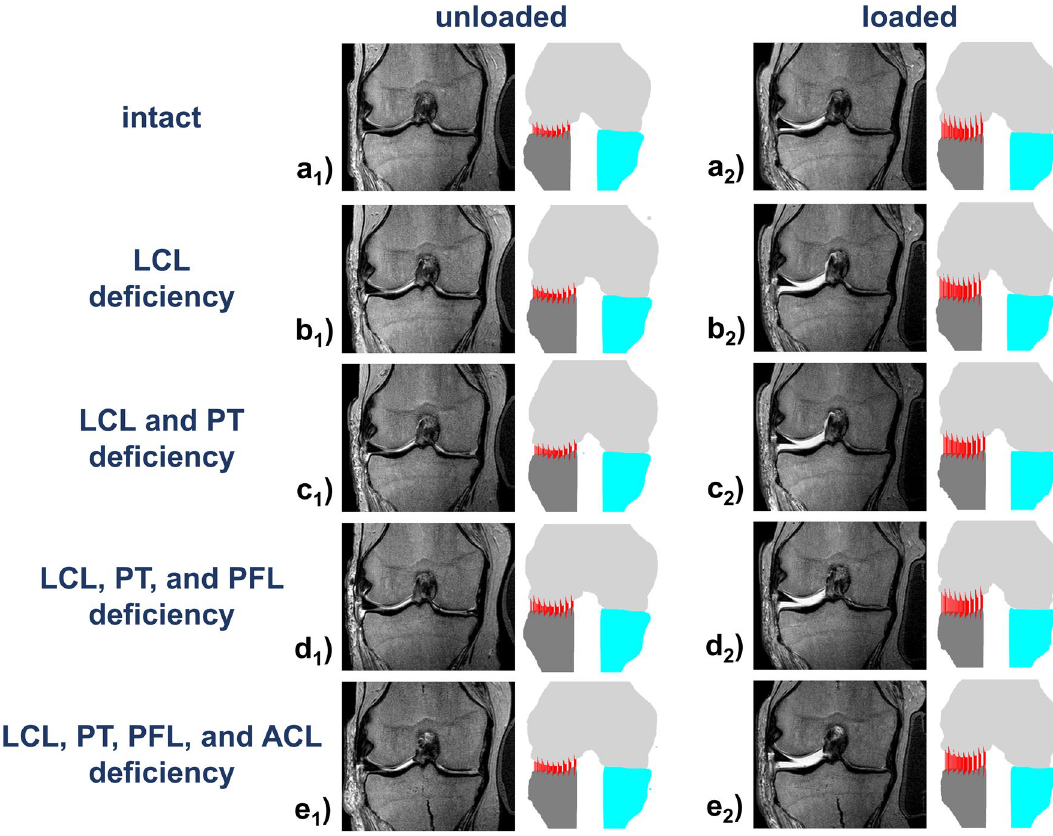
Figure 1. Visualization of the femorotibial joint as a function of varus loading and extent of injury to the posterolateral corner. Mid-coronal T2-weighted images (left) and corresponding visualizations of the 3D joint model (right) of a representative specimen in the loaded ( a 1 – e 1 ) and unloaded ( a 2 – e 2 ) configurations. Conditions are intact ( a ) and after surgical transections of the lateral collateral ligament (LCL, b ), popliteus tendon (PT, c ), popliteofibular ligament (PFL, d ), and anterior cruciate ligament (ACL, e ). Color codes are light grey for the femur, turquoise for the medial tibia, and dark grey for the lateral tibia. Vertical red lines indicate individual subchondral cortical distances used for computational